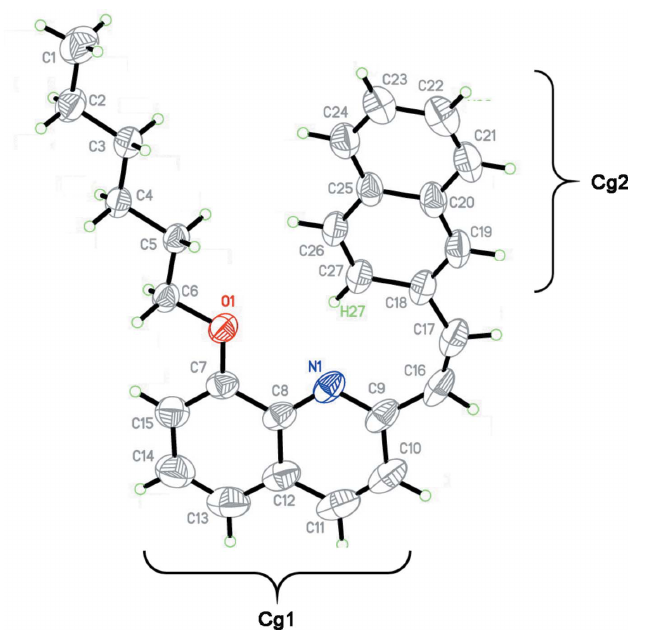
Figure 1 Molecular structure of compound ( 1 ) with atom labelling. Atomic displacement ellipsoids are drawn at the 30% probability